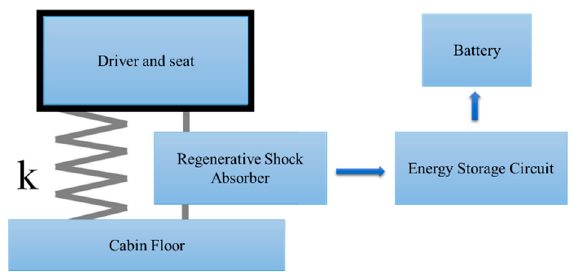
Figure 11. Schematic of the regenerative seat suspension system [89].